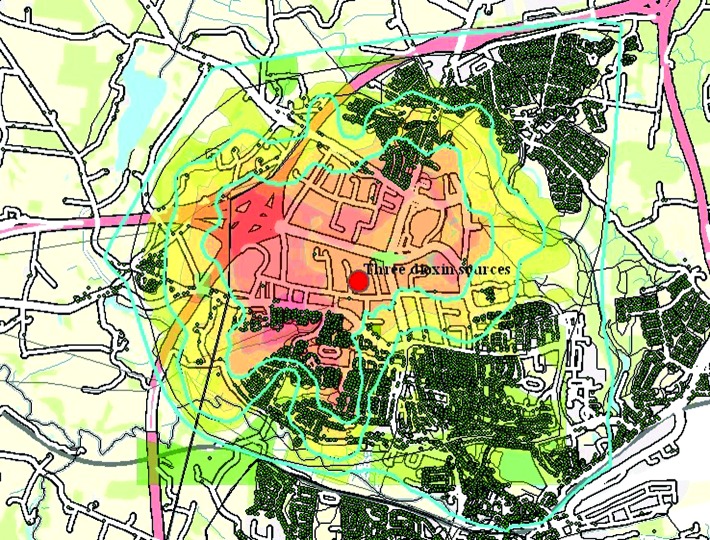
Computer-simulated exposure of dioxin from three sources (red) are layered onto the electronic map (GIS) and seen as different colored bands, with highest dioxin immissions in bright red and lowest in faint green. The immission concentration band borders (blue) are used to demarcate the three zones used for analyses of cancer development.